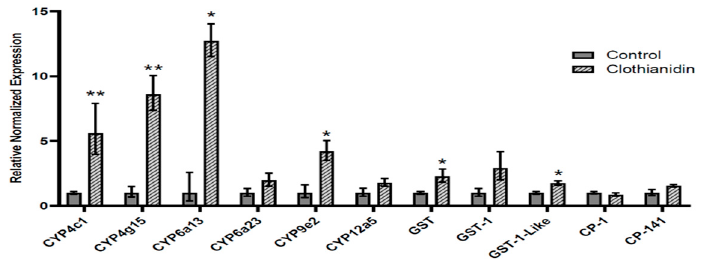
Figure 2. Transcript levels, normalized to RP-18 , in insects submitted to clothianidin versus control insects. Data are mean standardized transcript levels (mean ± SEM, n = 4–5). Asterisks depict results that are significantly different (* p < 0.05, ** p < 0.01).